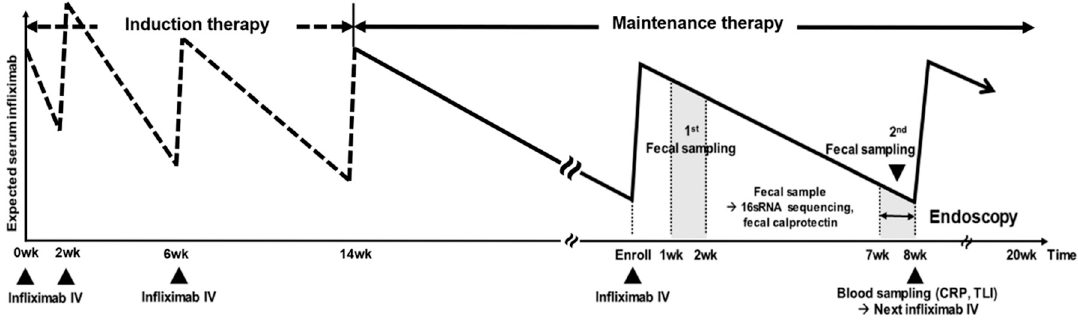
Figure 1. Fecal and blood sampling process. CRP: C-reactive protein, TLI: Trough level of infliximab.